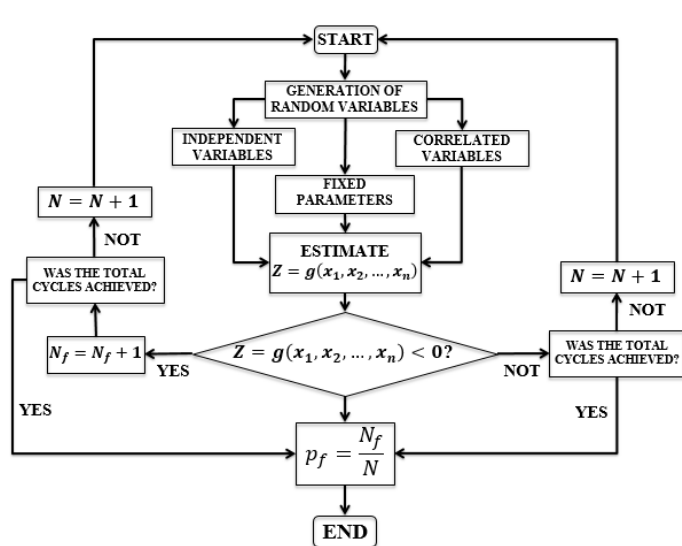
Figure 2. Flowchart of the MCS